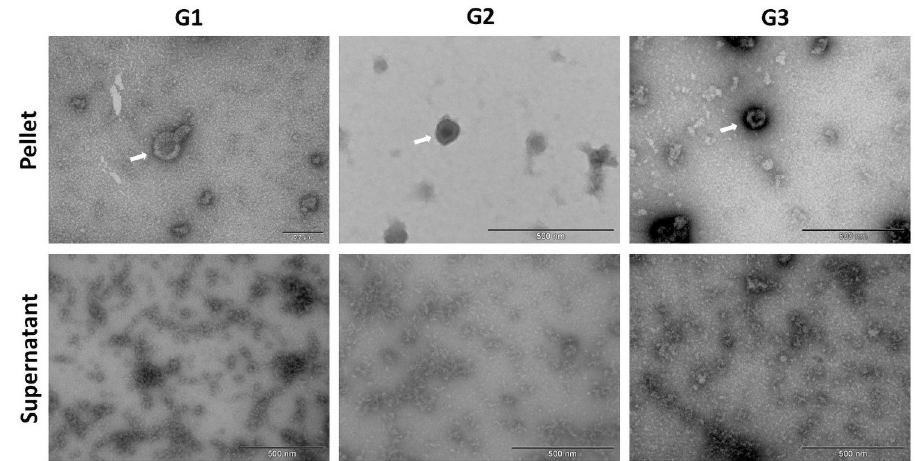
Fig 6. Morphology of bovine milk-derived exosomes isolated via the ExoQuick (EQ) method and visualized by Transmission Electron Microscopy (TEM). Group (G)1: whole milk frozen immediately upon collection and processed post-thaw. G2: Whole milk processed to remove fat globules and cream prior to ultracold storage. G3: Whole milk processed to remove fat globules, cream, milk cells, and casein proteins prior to ultracold storage. Scale bars: 200 nm—500 nm.